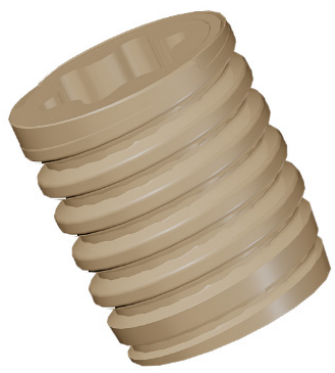
Figure 8. 3D rendered image of the PEEK